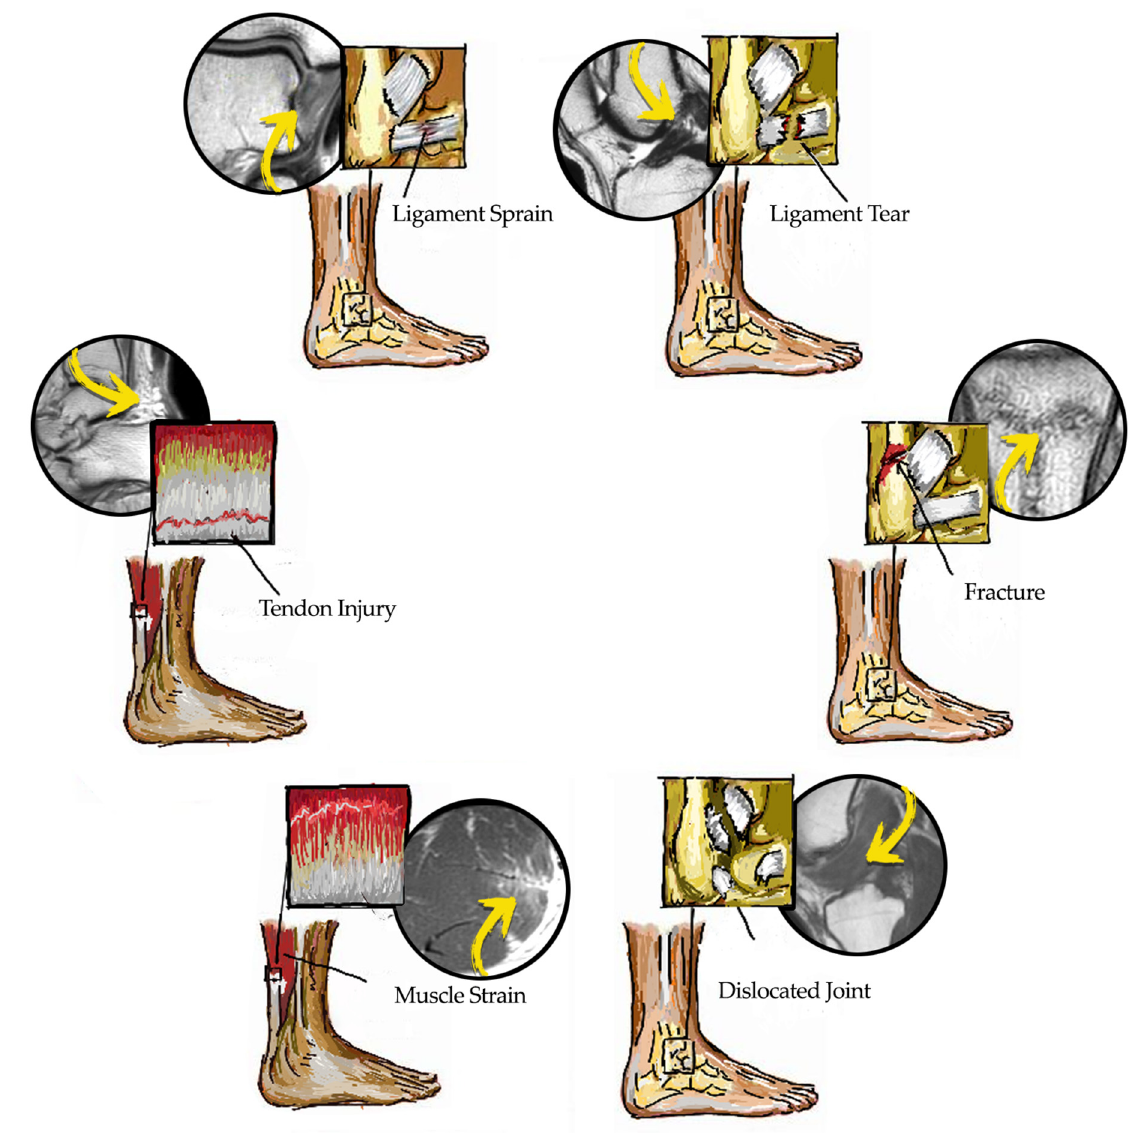
Figure 1. Main sports-related traumatic musculoskeletal injuries (graphical model and magnetic resonance imaging).